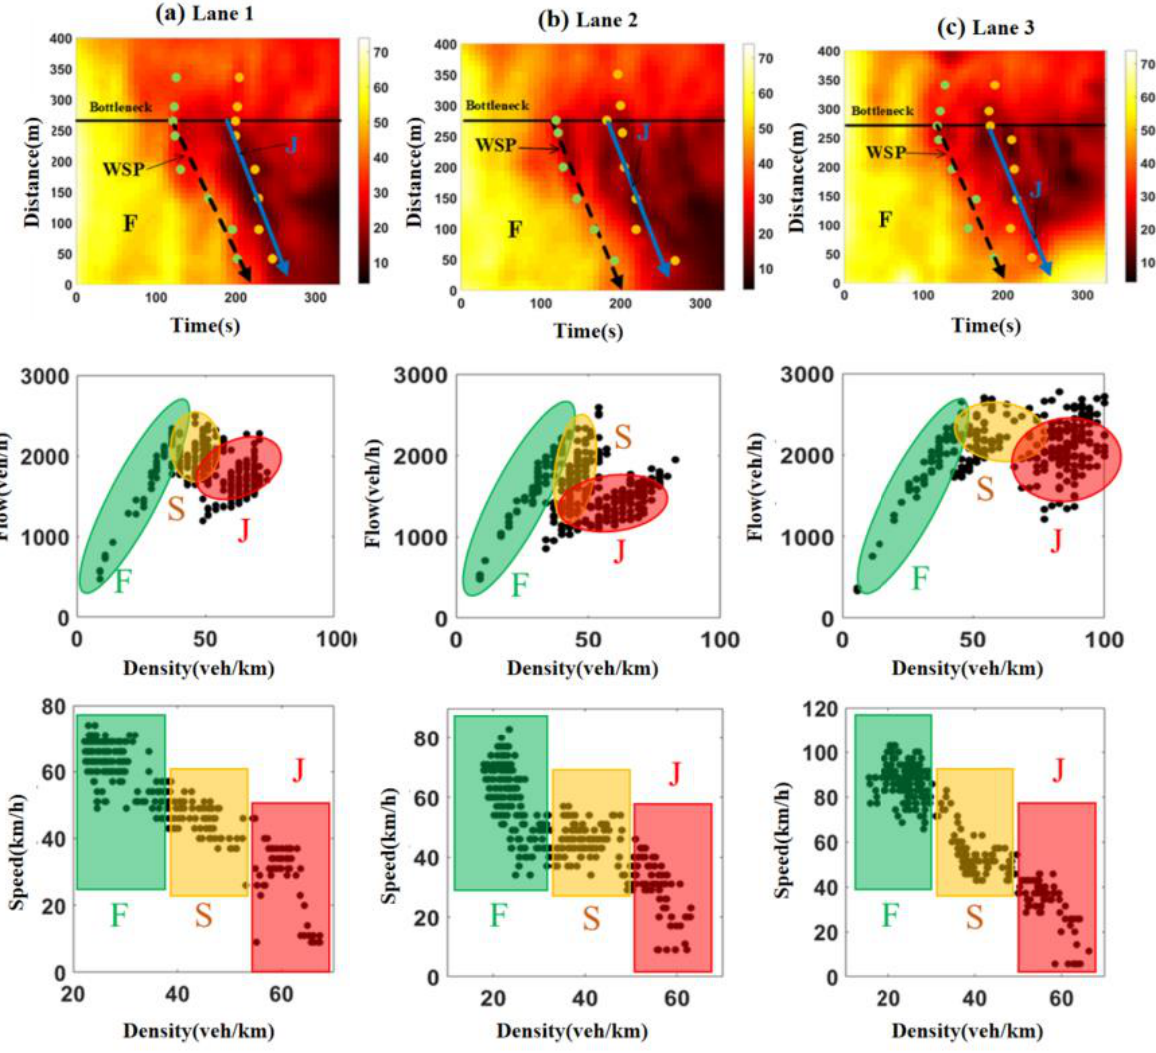
Figure 3. Analysis of tunnel capacity drop based on three-phase traffic flow.